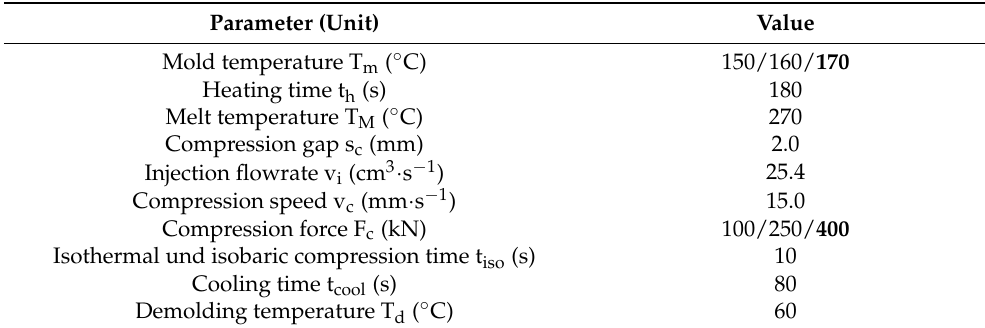
Table 2. Main process parameters of the production of the plate specimens for the determination of the electrical conductivity (bold values) and the achievable plate aspect ratio as well as thickness dimensional accuracy.